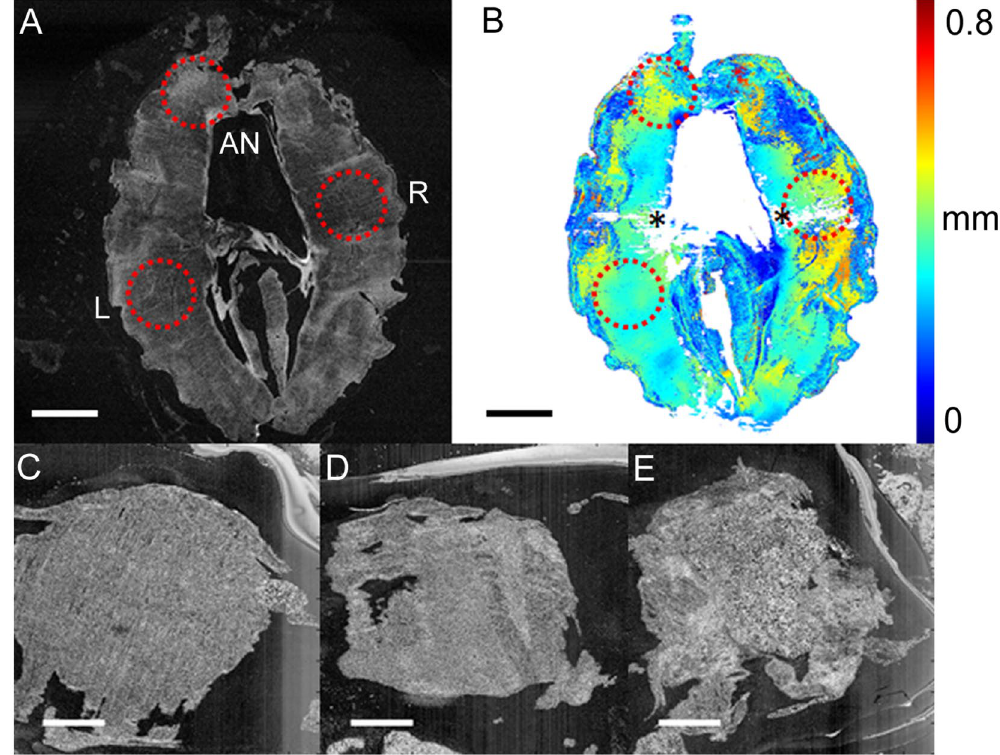
Figure 3. Transverse ( en face ) images of diaphragm recorded by OCT ( A ). Circles indicate the locations (left and right lateral, L and R) and anterior (AN) at which indentation was performed. Thickness map of the diaphragm ( B ); asterisks denote artefacts in thickness detection. At left and right lateral locations, normal diaphragm fibre orientation is evident in the Control group ( C ), compared with the Dox group ( D ), where connective tissue (speckled white appearance) occludes muscle. At anterior locations, diaphragm in the Control group was associated with adipose tissue, exhibiting a porous or spongy appearance ( E ). Scale bar is equal to 3 mm in ( A) and ( B ), and 1 mm in ( C–E)